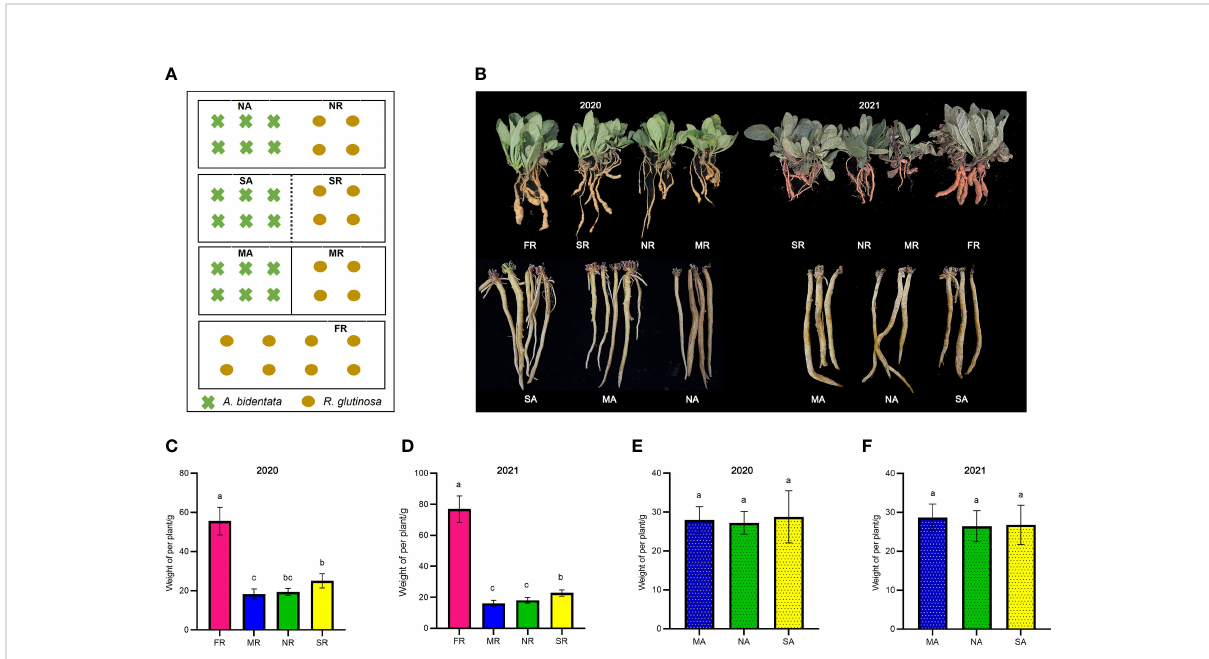
FIGURE 1 Phenotypic distribution of yield traits. The schematic diagram of experimental design (A) . The picture of plant growth in 2020 and 2021 (B) . The Fresh weight of R. glutinosa root in 2020 and 2021 (C, D) . The Fresh weight of (A) bidentata root in 2020 and 2021 (E, F) . FR, newly planted R. glutinosa ; MR, plastic fi lm barrier treatment R. glutinosa ; MA, plastic fi lm barrier treatment A.bidentata ; SR, nylon mesh barrier treatment R. glutinosa ; SA, nylon mesh barrier treatment A.bidentata ; NR, no root barrier R. glutinosa ; NA, no root barrier A.bidentata ; the same below. Different letters in columns show signi fi cant differences determined by LSD ’ s test (p<0.05,